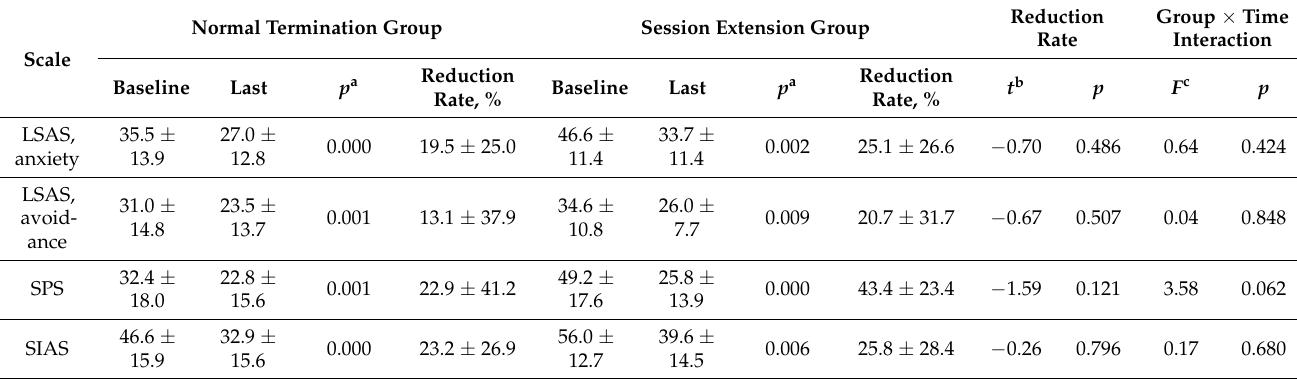
Table 3. Changes in the psychological scale scores in the last session compared with the baseline scores in the normal termination and session extension